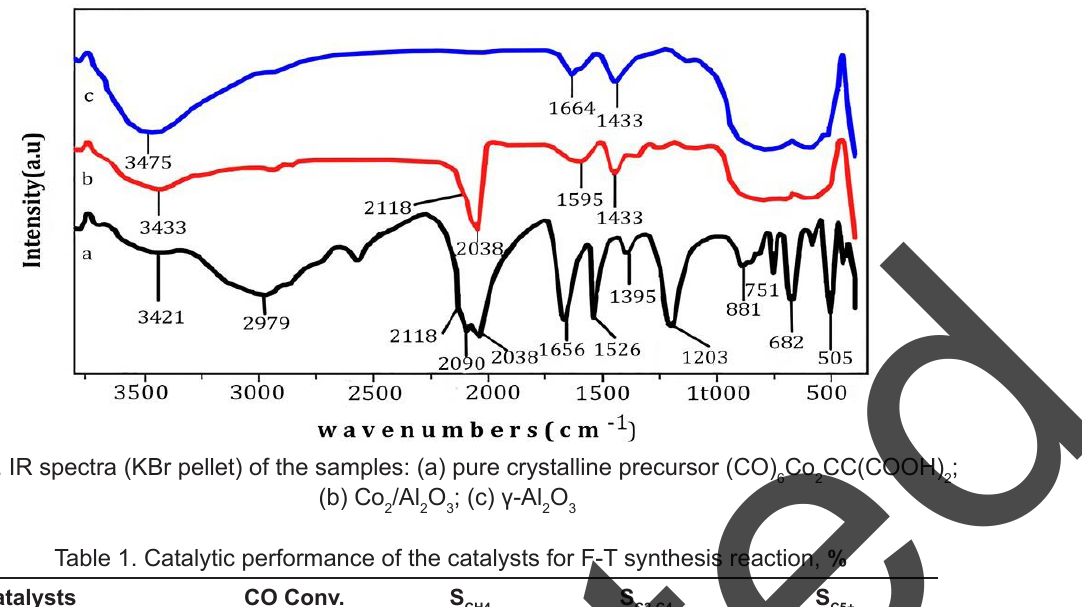
Co CC(COOH) ; 6 2 2